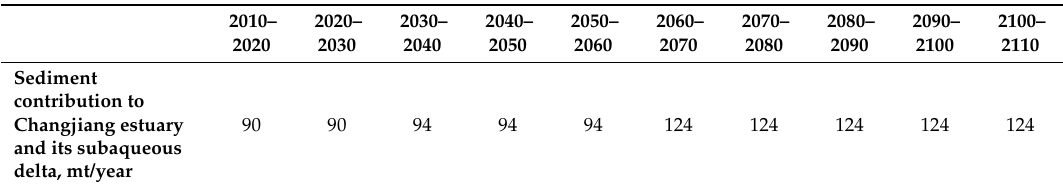
Table 2. Estimated sediment contributing to the Yangtze estuary and its subaqueous delta after completion of the TGD (obtained from Yang et al.